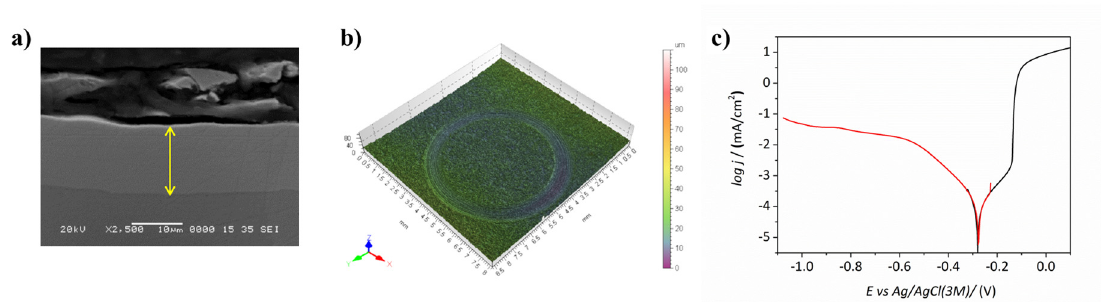
Figure 12. Confirmation test results for ( a ) thickness, ( b ) wear and ( c ) corrosion performance of coatings obtained from multivariate